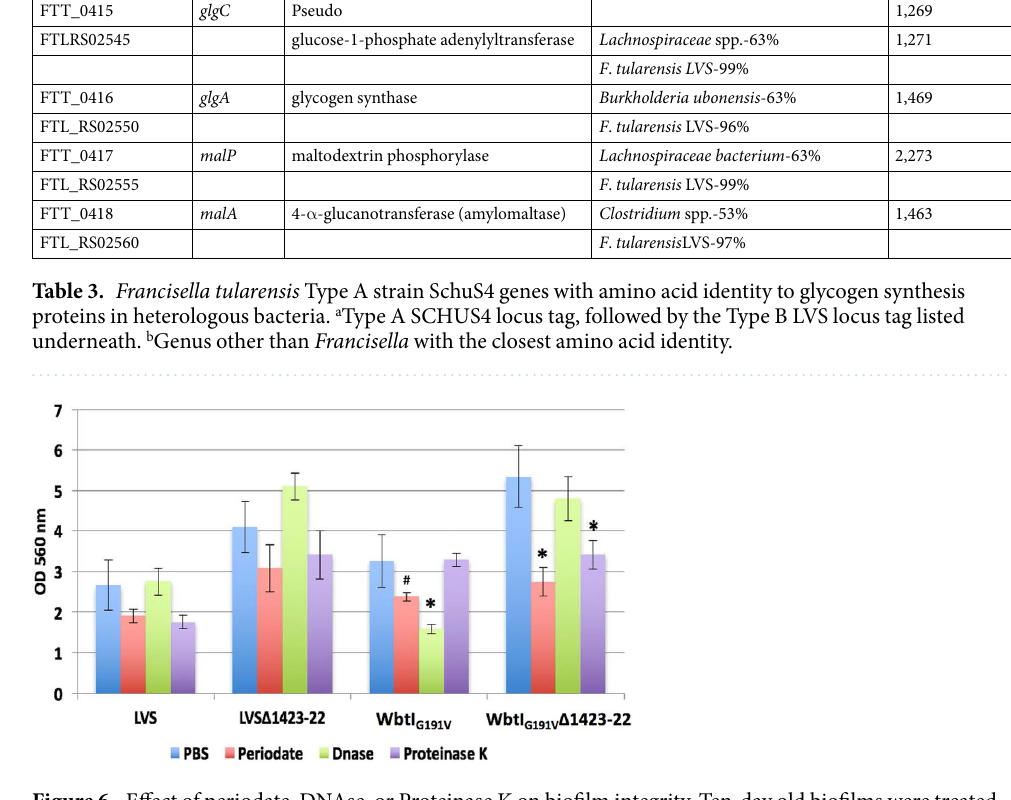
Figure 6. Effect of periodate, DNAse, or Proteinase K on biofilm integrity. Ten-day old biofilms were treated with sodium m -periodate, DNase, Proteinase K, or PBS for two hours at 37 °C, washed with distilled water and left to dry overnight before CV staining. Only WbtI G191V and WbtI G191V Δ 1423-22 contained significantly less biofilm ( # p = 0.0246, * p = 0.0055) after periodate treatment when compared to untreated biofilm from the same strain, indicating these strains may produce more of the glucan EPS in their biofilms compared with the LVS parent strain. The WbtI G191V biofilm only was significantly diminished after treatment with DNase ( * p = 0.0190), whereas only the WbtI G191V Δ 1423-22 biofilm was significantly affected by treatment with Proteinase K ( * p =